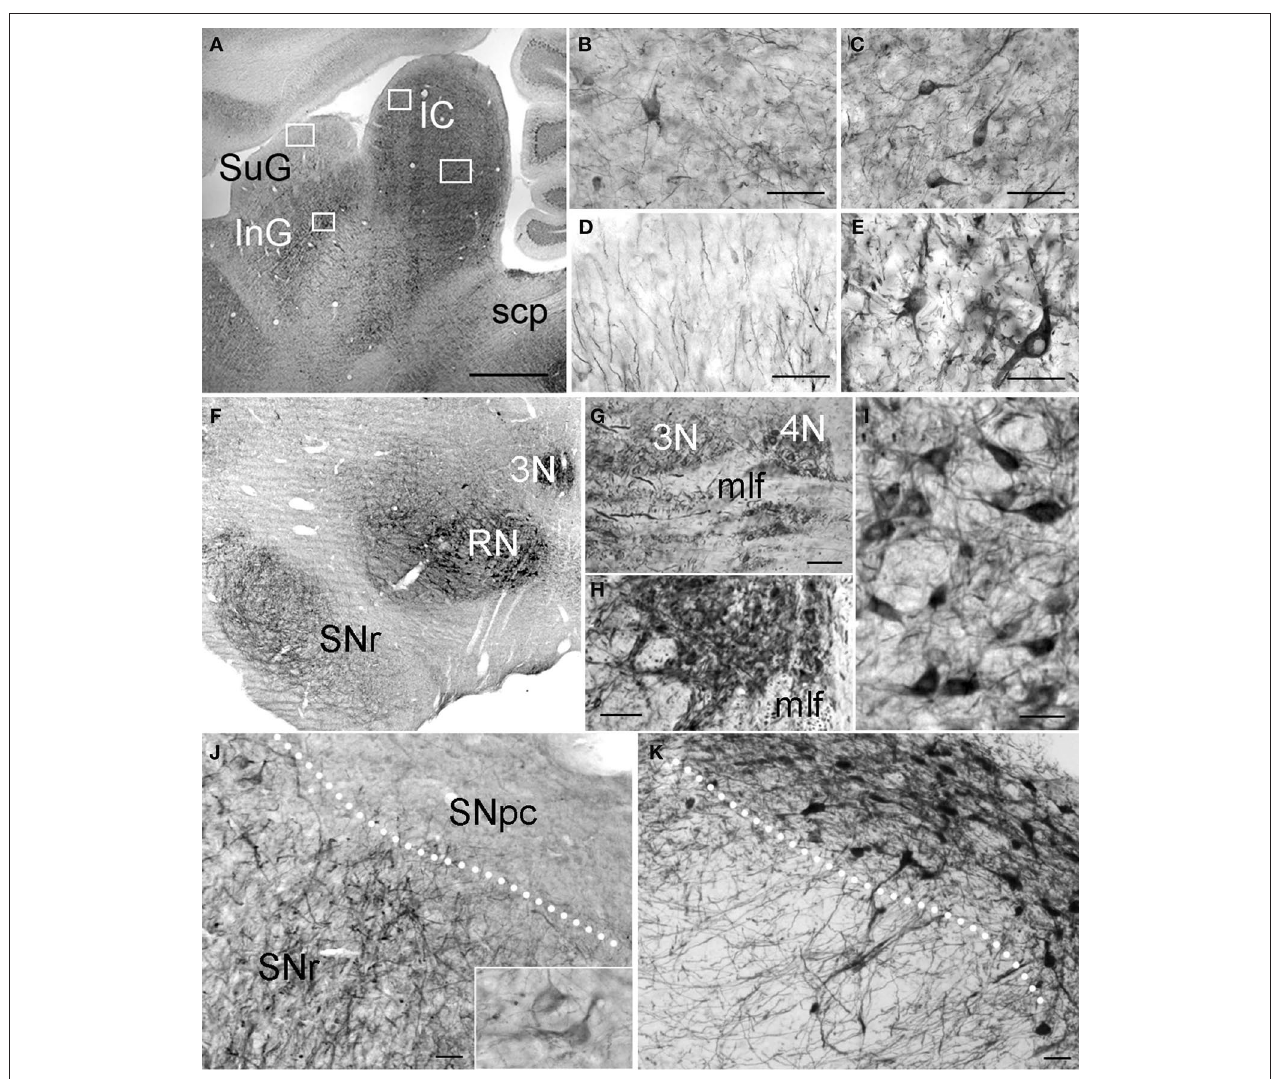
Figure 9 | PlexinA4 in the midbrain. Micrographs of sagittal ( A–e and g ) and coronal (F,H–K) sections through the adult rat midbrain immunostained for PlexinA4 (A–J) or tyrosine hydroxylase (K) . PlexinA4 reaction product is seen in many neurons in both the inferior (IC) and superior colliculi (SC; A–e ). In the IC, immunoreactive cell bodies and fibers are present in the external cortex (ECIC; B ) and the central nucleus (CIC; C ). In the SC, labeled fibers are visible in the superficial gray layer (SuG; D ) whereas immunoreactive neuronal cell bodies and fibers are present in the deep gray layer (e) . PlexinA4 staining was also present in neurons in the oculomotor (3N; F–H ) and throchlear nuclei (4N; F and g ), RN